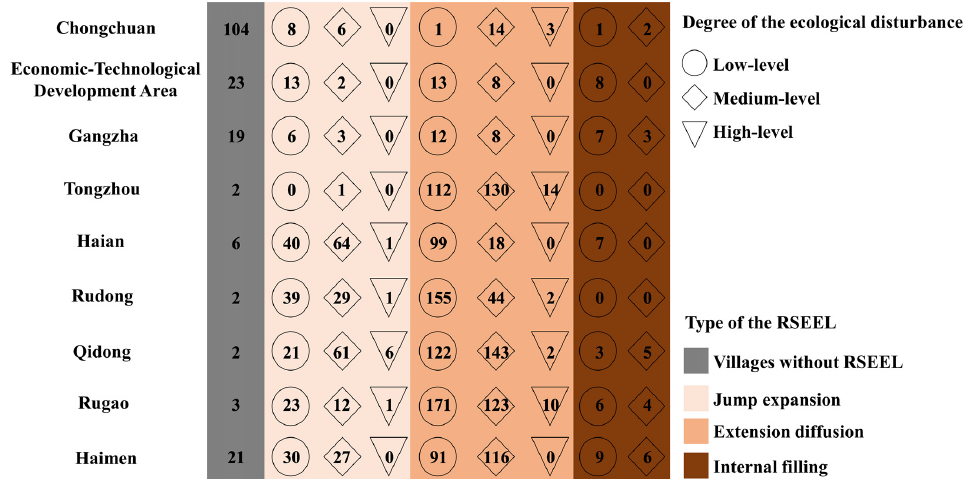
Figure 8. The dominant type of RSEEL at the village level in Nantong.